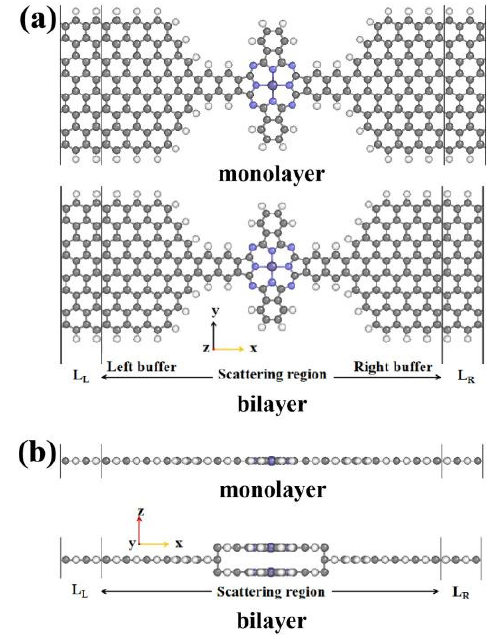
Figure 1. The structure of the monolayer and bilayer MPc (M = Cu, Fe, Co) molecular devices. The navy, blue, black, and grey balls represent M, N, C, and H atoms, respectively. The molecule in the scattering region is MPc, the electrode is V-shaped zigzag-edged GNRs. ( a , b ) are the top and side view of the molecular device.